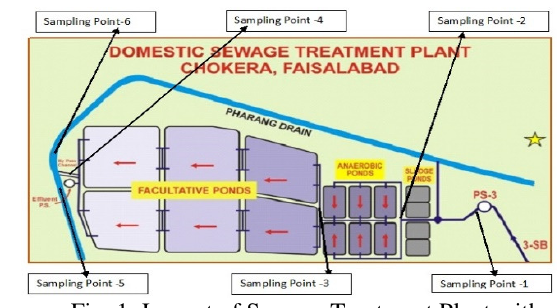
Fig. 1: Layout of Sewage Treatment Plant